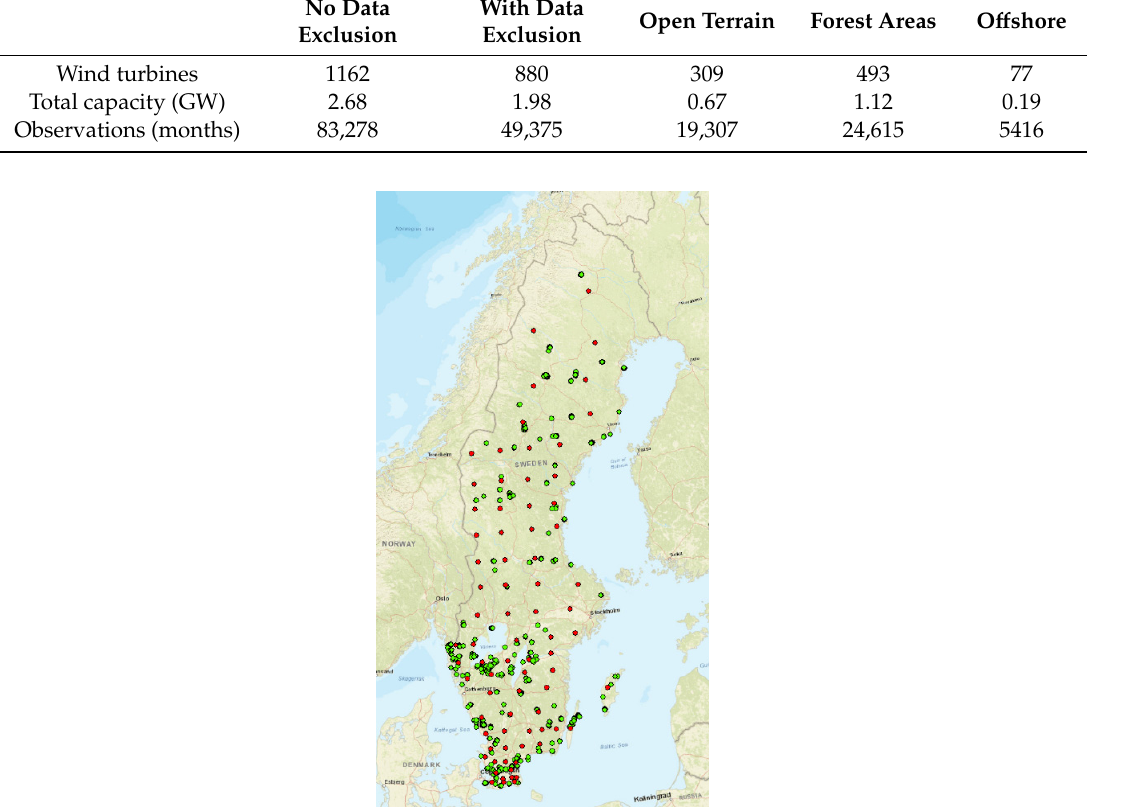
Table 1. Vindstat data used for this study. In the columns to the right, the wind turbines after data exclusion are divided into three terrain types.